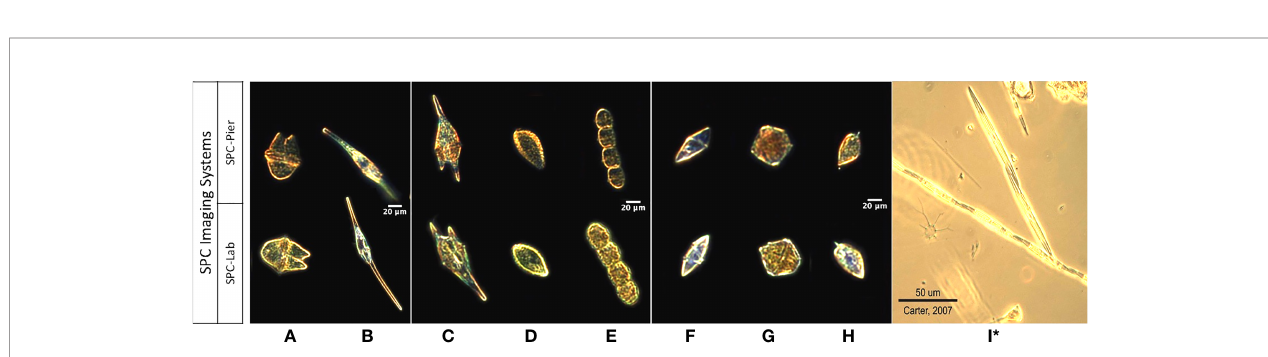
FIGURE 2 | Images of 9 taxa from the SPC-Pier, SPC-Lab systems. (A – I) Akashiwo sanguinea , Ceratium furca , Chattonella spp., Cochlodinium spp., Gyrodinium spp., Lingulodinium polyedra , Prorocentrum micans , and Pseudo-nitzschia spp. (I) * Is a lab microscopy photo of Pseudo-nitzschia sp. as the SPC imaging systems produced unsuitable